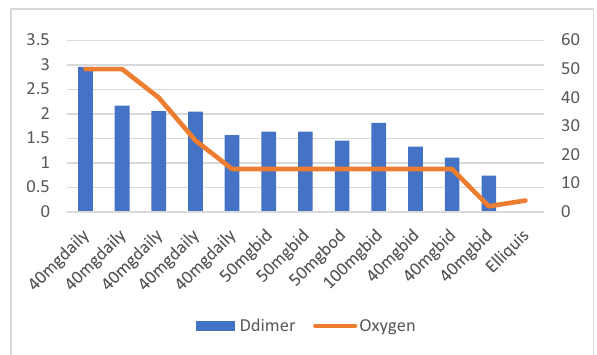
Figure 3: Patient number 3 presented at a later stage requiring high fl ow nasal canula oxygen and D - dimer level was also moderately high on presentation. The fi gure demonstrates that increase or decrease in D - dimer trends is associated with increasing and decreasing trends of oxygen requirements. This patient was treated with intermediate dose of Enoxaparin ( 40 mg SubQ BID ) which was adjusted based on D - dimer trends. At some point, patient also received 100 mg SubQ BID dose of Enoxaparin due to increased D - dimer and patient responded appropriately and subsequently discharged home.